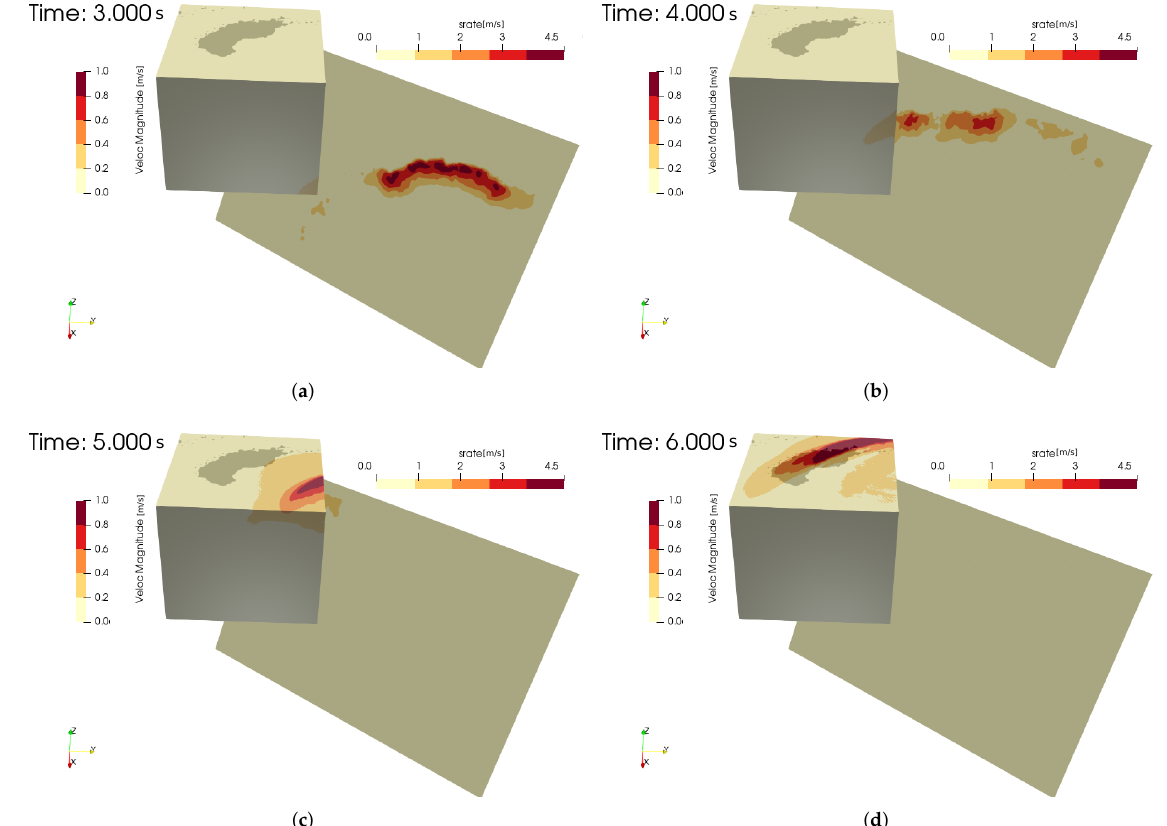
Figure 17. Contour plots at different time steps, of the particle velocity magnitude (in m/s) in a chunk of the Earth surrounding the sedimentary basin and of the slip rate on the fault plane (in m/s). ( a ) Snapshots of the particle velocity magnitude (in the crust) and slip rate magnitude (on the fault plane) at t = 3 s. ( b ) Snapshots of the particle velocity magnitude (in the crust) and slip rate magnitude (on the fault plane) at t = 4 s. ( c ) Snapshots of the particle velocity magnitude (in the crust) and slip rate magnitude (on the fault plane) at t = 5 s. ( d ) Snapshots of the particle velocity magnitude (in the crust) and slip rate magnitude (on the fault plane) at t = 6